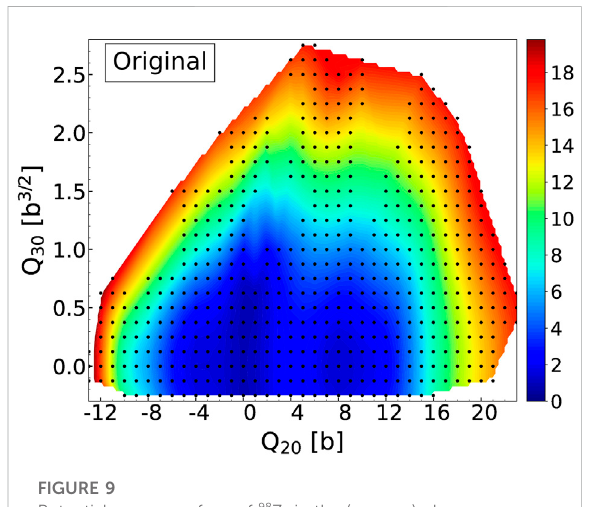
FIGURE 9 Potential energy surface of 98 Zr in the ( q 20 , q 30 ) plane. Converged HFBTHO solutions are represented by black dots. Energies given by the color bar are in MeV relatively to the ground